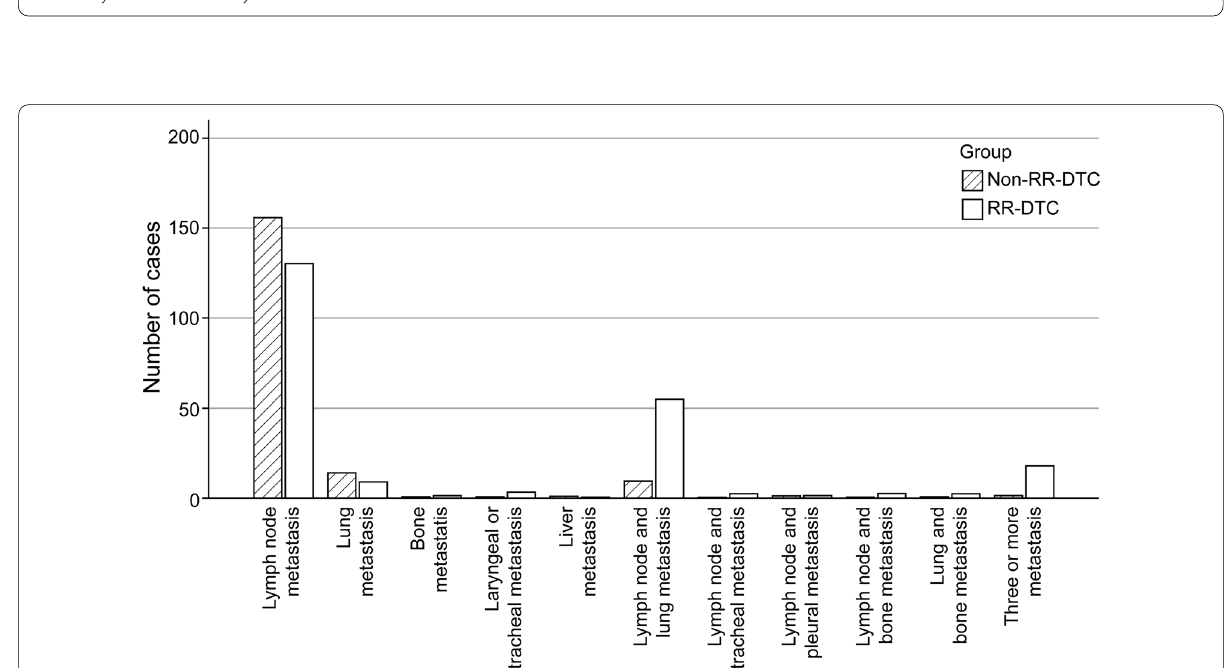
Fig. 2 Distribution of metastatic sites. The metastatic sites were divided into 11 groups: 1. Lymph node metastasis; 2. Lung metastasis; 3. Bone metastasis; 4. Laryngeal or tracheal metastasis; 5. Liver metastasis; 6. Lymph node and lung metastasis; 7. Lymph node and tracheal metastasis; 8. Lymph node and pleural metastasis; 9. Lymph node and bone metastasis; 10. Lung and bone metastasis; and 11. Three or more metastatic sites. RR-DTC, radioiodine refractory differentiated thyroid